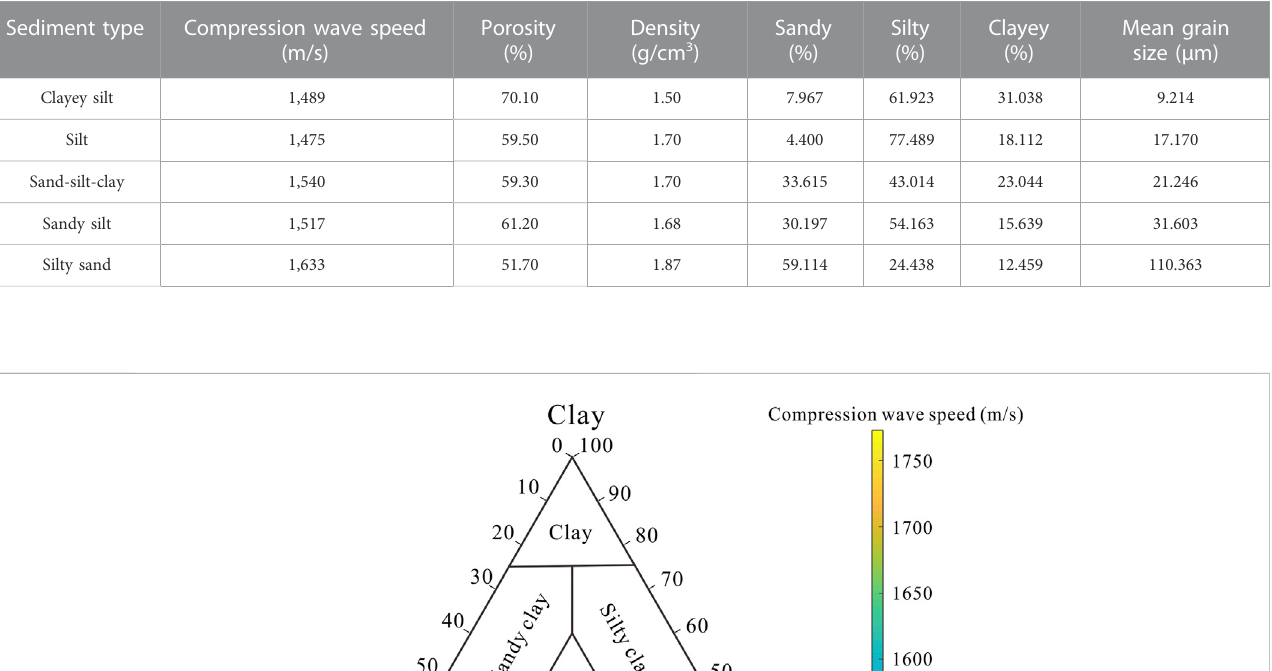
TABLE 1 Average values of the physical properties of the sea fl oor sediments.